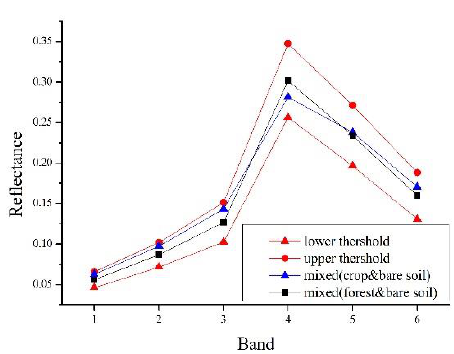
Figure 4. The spectra of pure pixel.